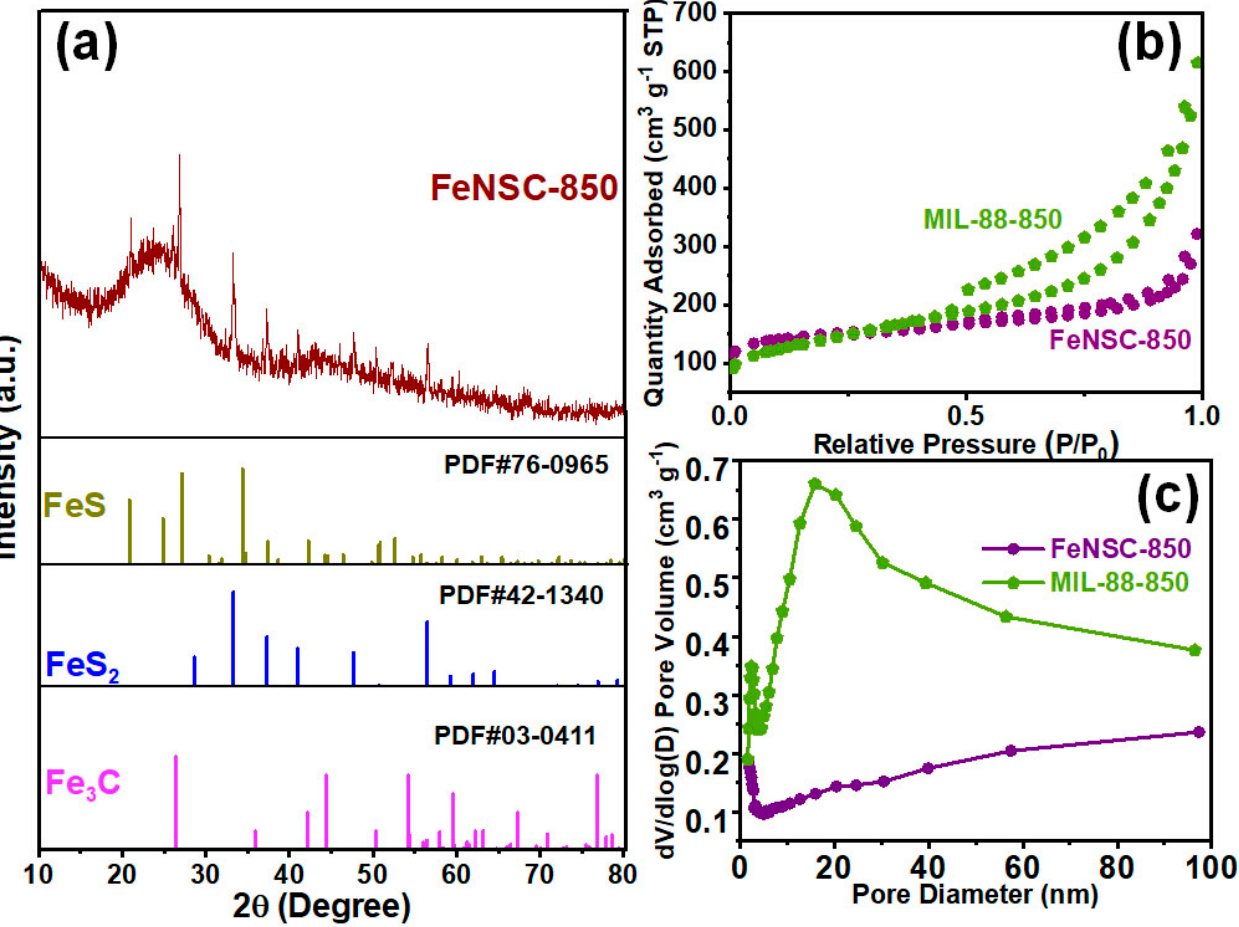
Figure 2. Physical characterizations of structure and composition of electrocatalysts: ( a ) X ‐ ray pow ‐ der diffraction pattern of FeNSC ‐ 850 accompanied by the standard XRD patterns of related sub ‐ stances of FeS (PDF#76 − 0965), FeS 2 (PDF#42 − 1340), and Fe 3 C (PDF#03 − 0411); ( b ) N 2 adsorption–de ‐ sorption isotherms and ( c ) corresponding pore size distributions of FeNSC ‐ 850 and MIL ‐ 88 ‐ 850.